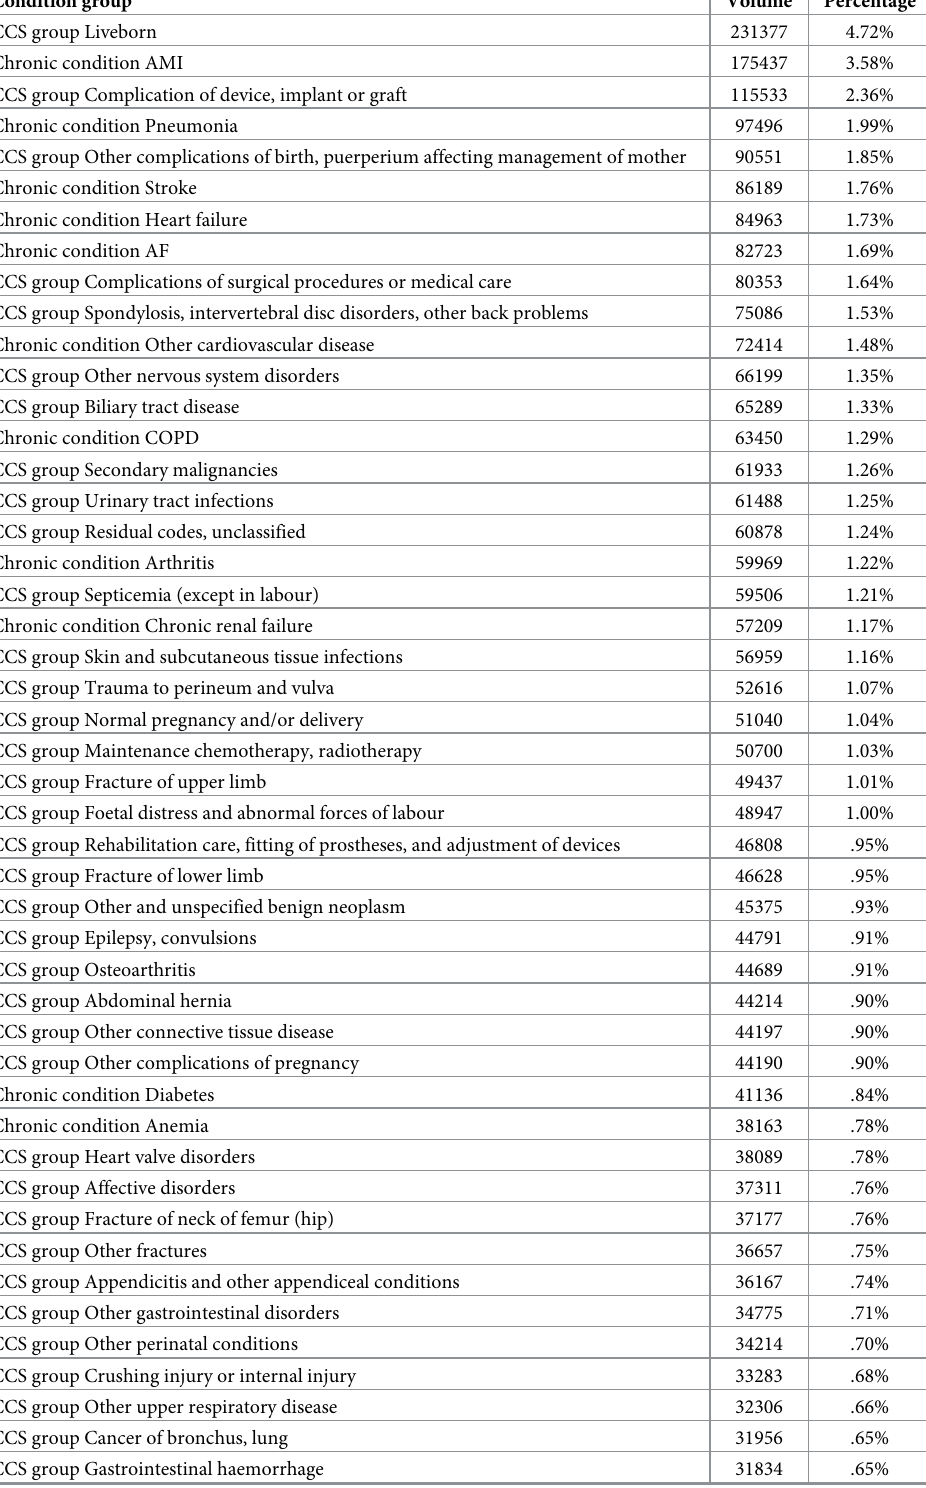
Table 2. Most common CCS groups and chronic conditions as primary cause of initial